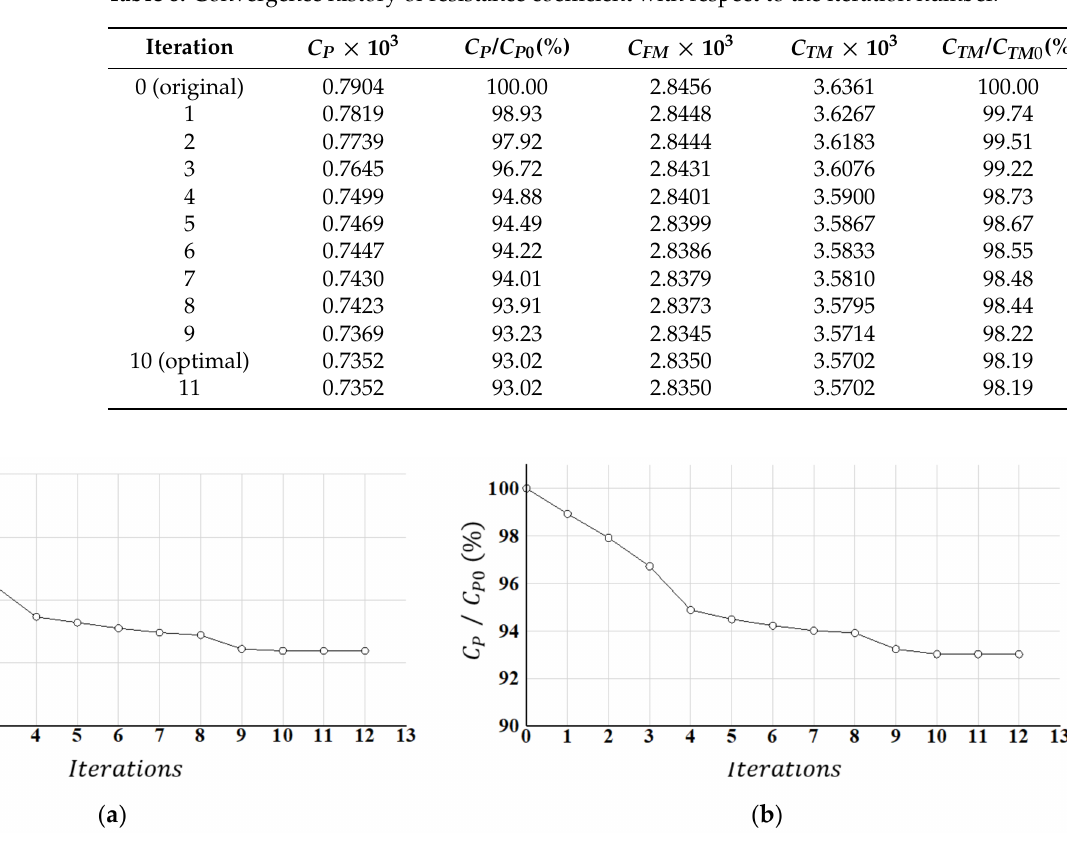
Table 8. Convergence history of resistance coefficient with respect to the iteration number.